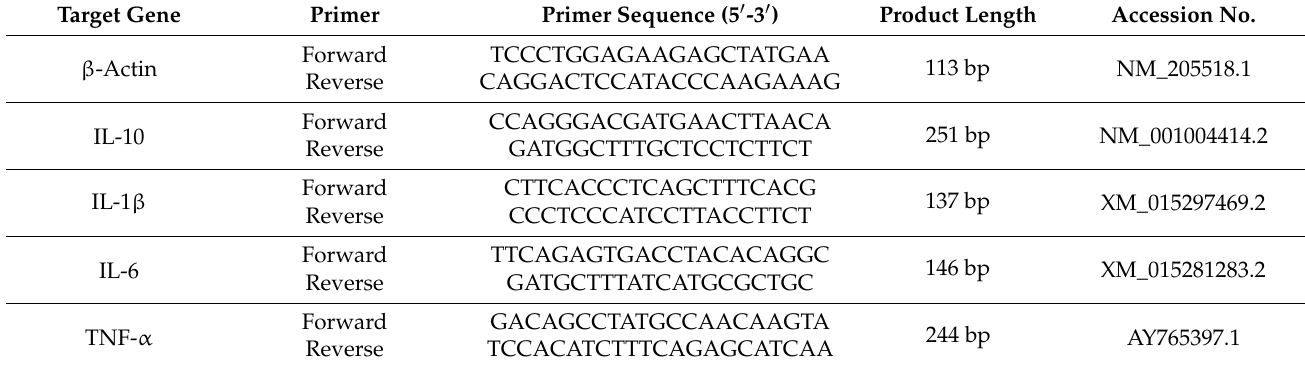
Table 2. Primer used for real-time quantitative fluorescence PCR analysis. Target Gene